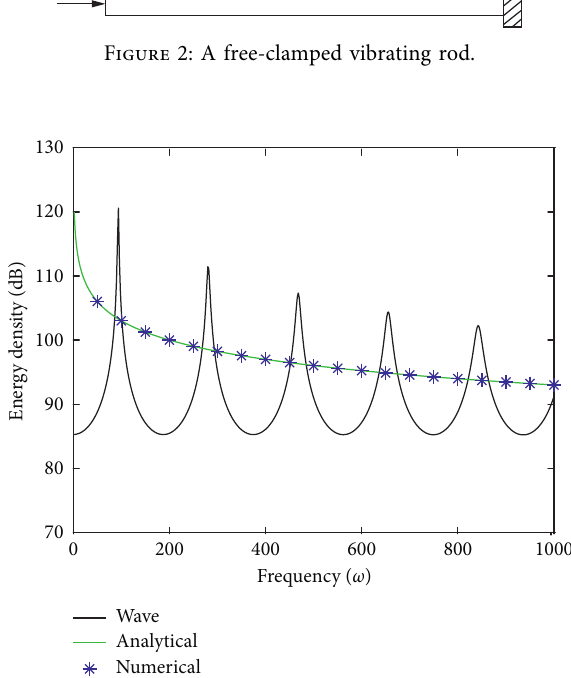
Figure 3: Energy densities of the rod in frequency field. The reference energy density is 10 − 12 J/m 2 .